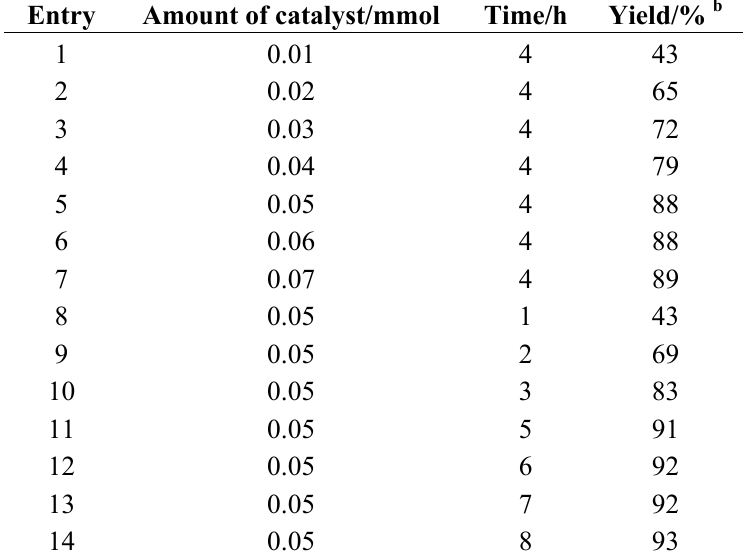
Table 2. Effects of the amount of catalyst and reaction time on the Mannich reaction a . Entry